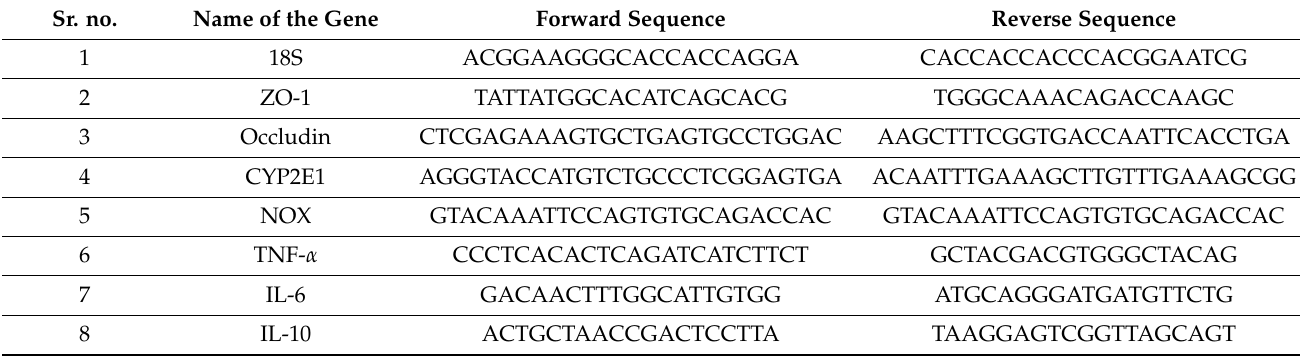
Table 2. List of Rat colon